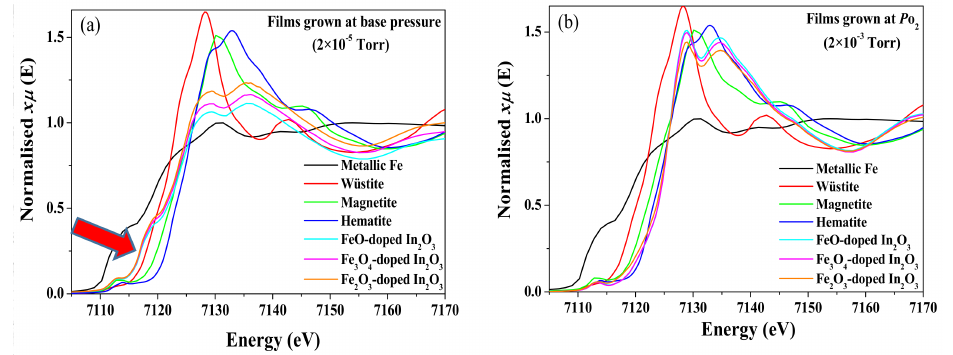
Figure 2. K-edge X-ray absorption near edge structure (XANES) spectra of reference compounds of metallic Fe, FeO, Fe 3 O 4 and Fe 2 O 3 and the Fe-doped In 2 O 3 films grown from di ff erent precursors at ( a ) at base pressure of 2 × 10 − 5 Torr; where an arrow at 7117 eV indicates an additional absorption and ( b ) higher partial oxygen pressure of 2 × 10 − 3